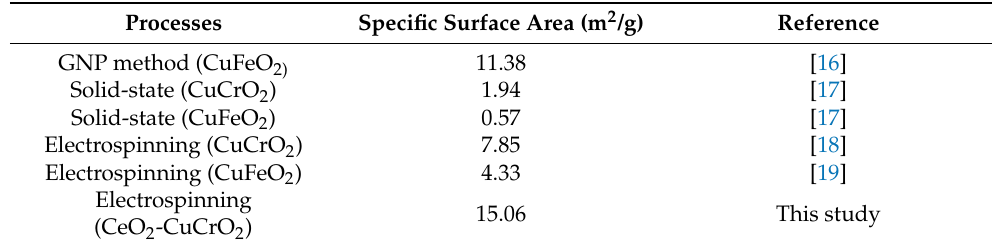
Table 1. Specific surface area of the different delafossite materials prepared by various processes.